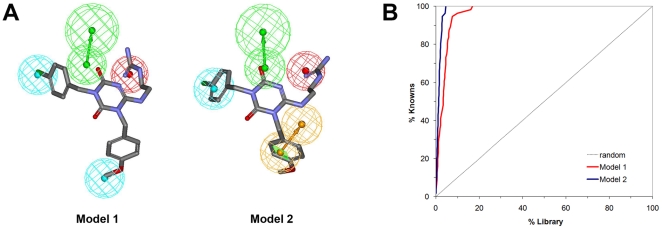
Ligand-based pharmacophore models recapture the known binders.(A) ligand-based four-feature pharmacophores used for virtual screening, with mapping of a known active small-molecule antagonist used for constructing the pharmacophores. The pharmacophores are represented as tolerance spheres with directional vectors where applicable. Green spheres represent hydrogen bond acceptors, red - positive ionizable, light blue – hydrophobic, and orange - aromatic ring. (B) ROC curve demonstrating the enrichment achieved following ligand-based pharmacophore mapping of 56 known active PKR antagonists and 5909 random molecules obtained from the ZINC database. Known actives are significantly enriched by both pharmacophore hypotheses.